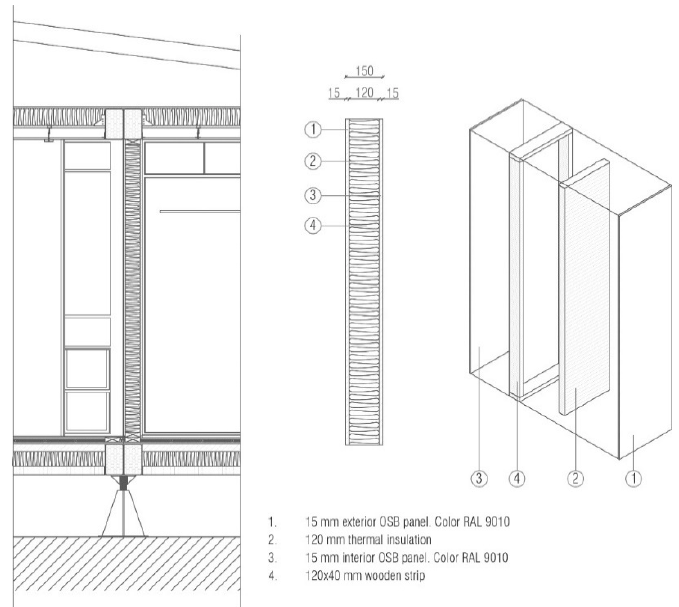
Figure 17. Exterior facade without thermal inertia.